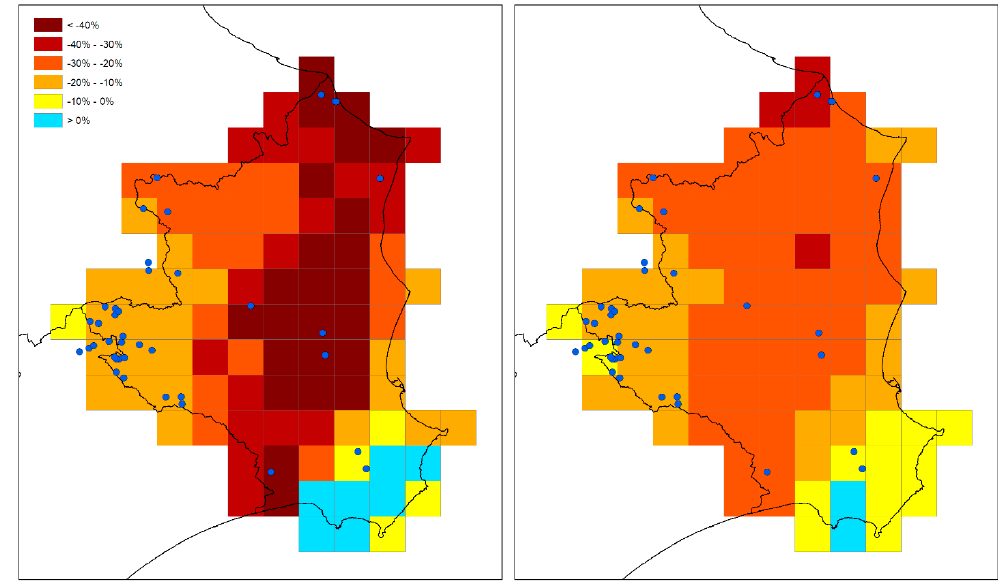
Figure 4. Projected percent changes (2016–2050 vs. 1971–2005) of baseflow ( left ) and total runoff ( right ) in the province of Crotone. Source nodes are superimposed.